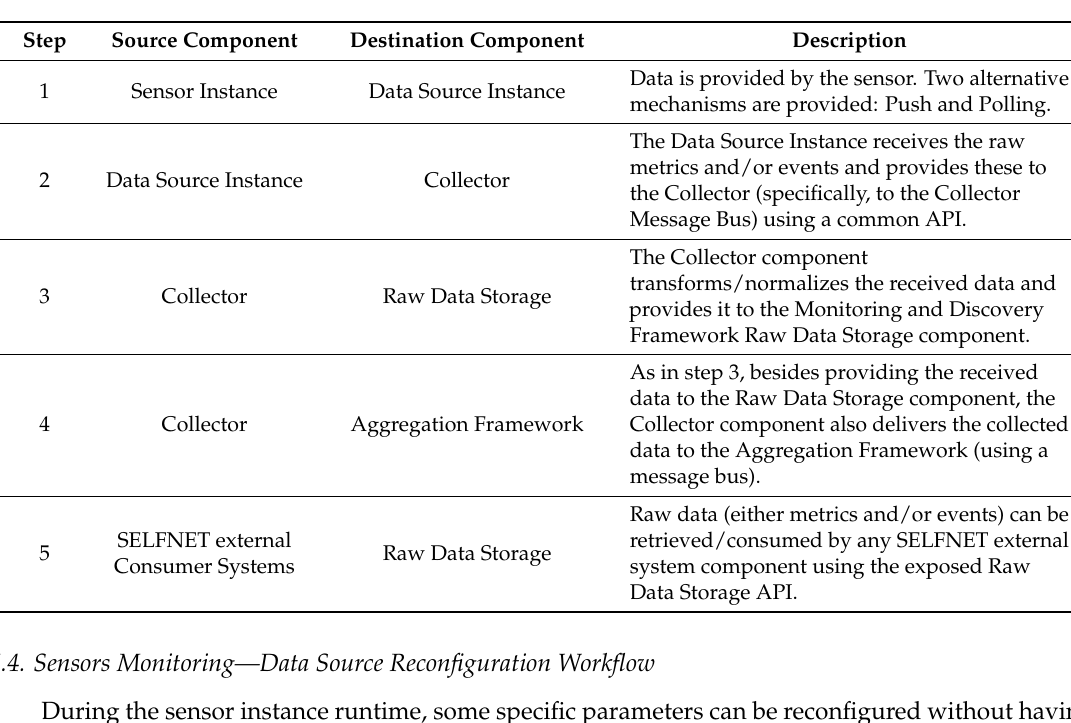
Table 8. Sensor Monitoring—Poll Metrics Workflow Steps.